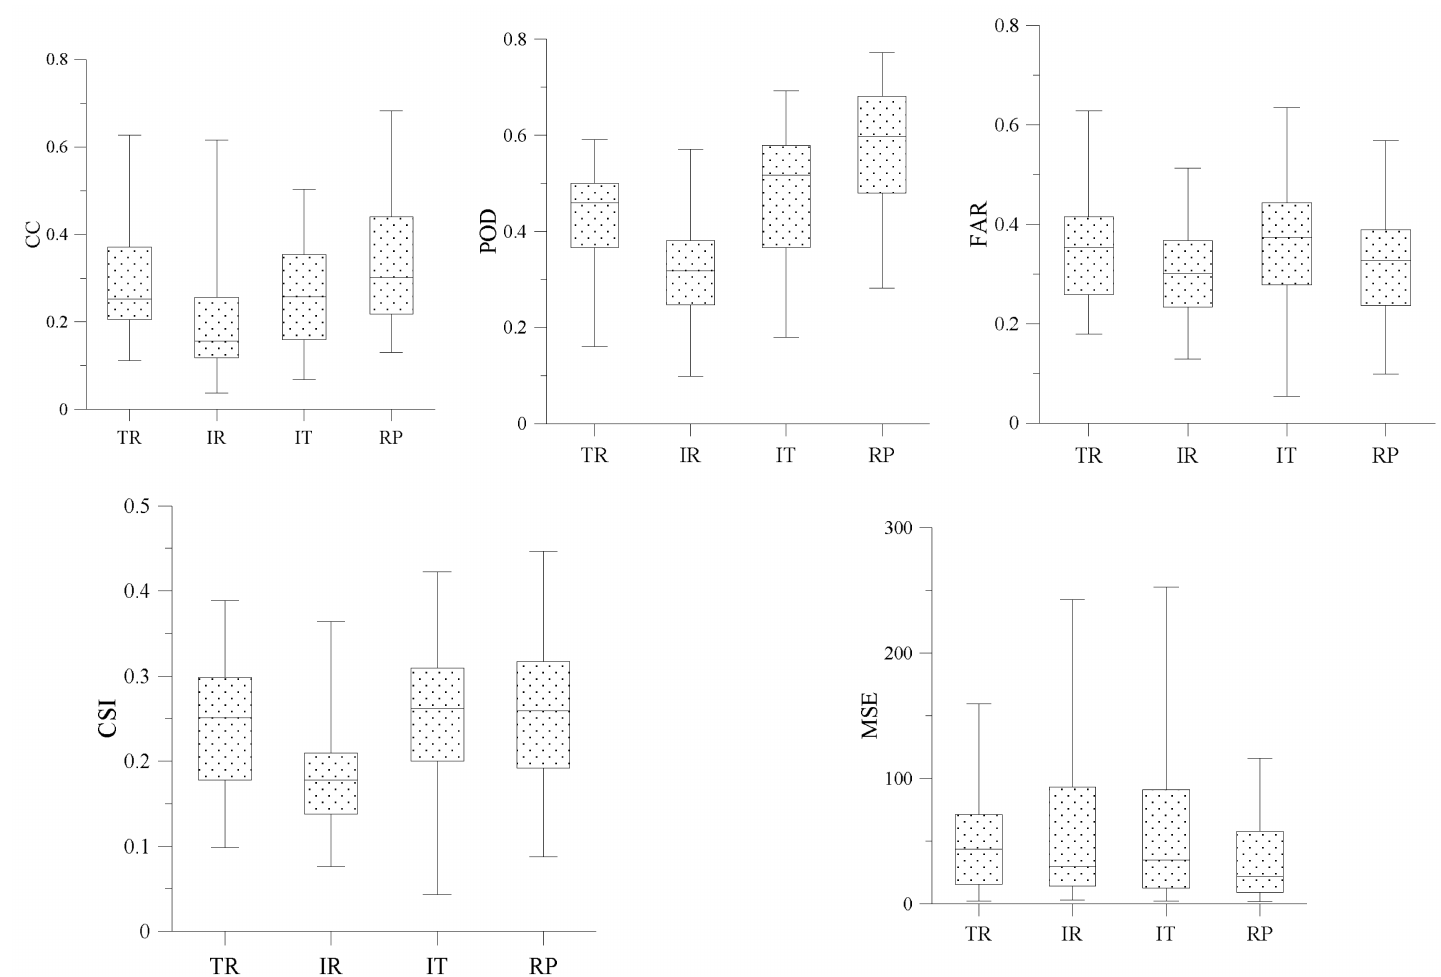
Figure 5. Comparative statistical summary of CC, POD, FAR, CSI, and MSE (mm 2 ) based performance of the TR, IR, IT, and